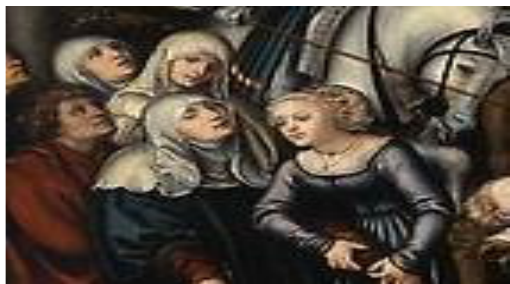
Figure 4. The Crucifixion (1532), detail, painting on beech wood, 76 × 54.5 cm, Indianapolis Museum of Art, The Clowes Collection: https://lucascranach.org/en/US_IMA_2000-344, accessed on 27 February 2023).